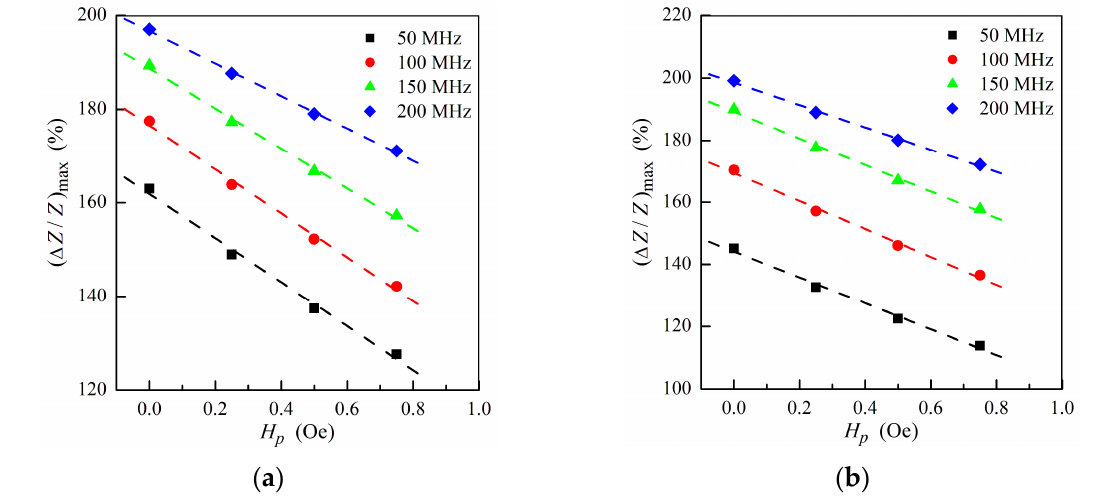
Figure 5. Maximum MI ratio ( ∆ Z / Z ) max as a function of the field H p at different frequencies for the multilayer with ferrogel placed onto the surface of thin layer ( m = 3, n = 4) ( a ) and onto the surface of thick layer ( m = 4, n = 3) ( b ) (see also Figure 1e,f). Other parameters used for calculations are the same as in Figure 2.